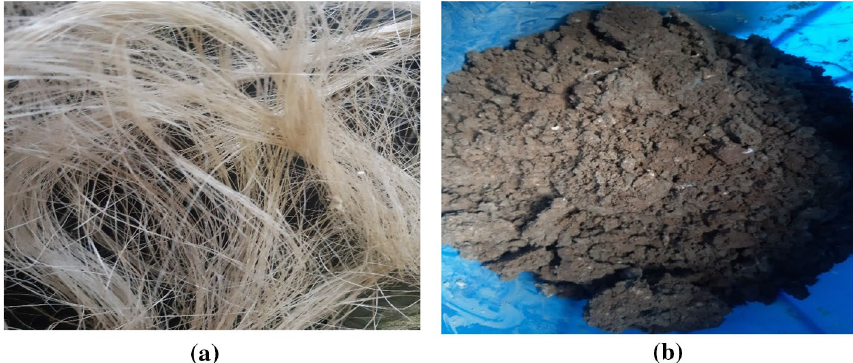
Figure 1. Image of materials used in the study ( a ) banana stem fiber ( b ) cement–sand–paper